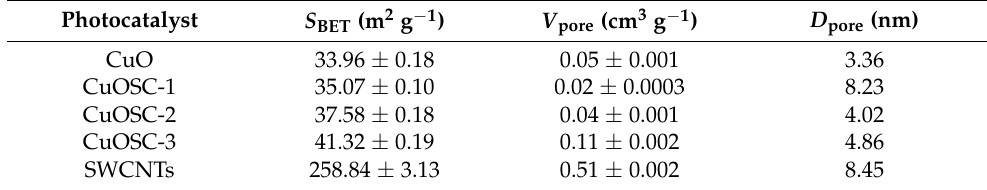
Table 1. The pore volume, pore size distribution, and specific surface areas (SFA) of the samples.